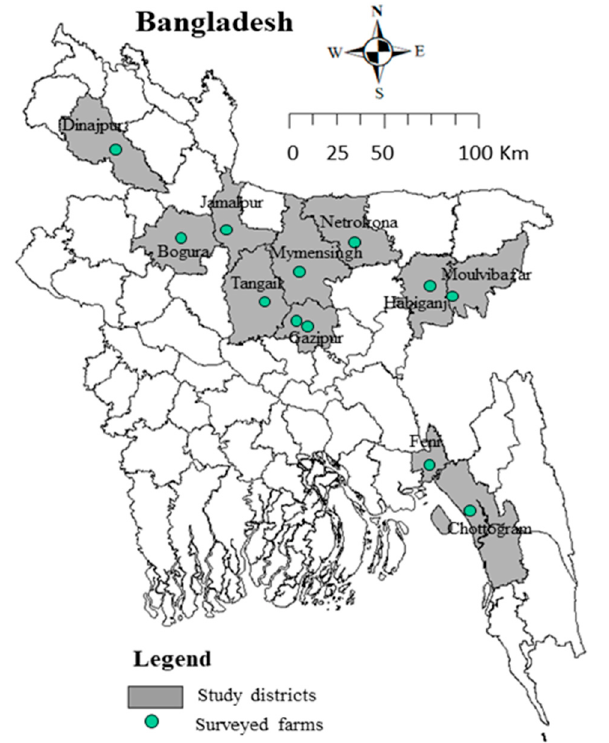
Figure 1. Location of 12 layer flocks of 11 districts (five administrative divisions) of Bangladesh were taken under this survey that involved three from Dhaka, three from Mymensingh, two from Rangpur, two from Sylhet, and two from Chattogram division.